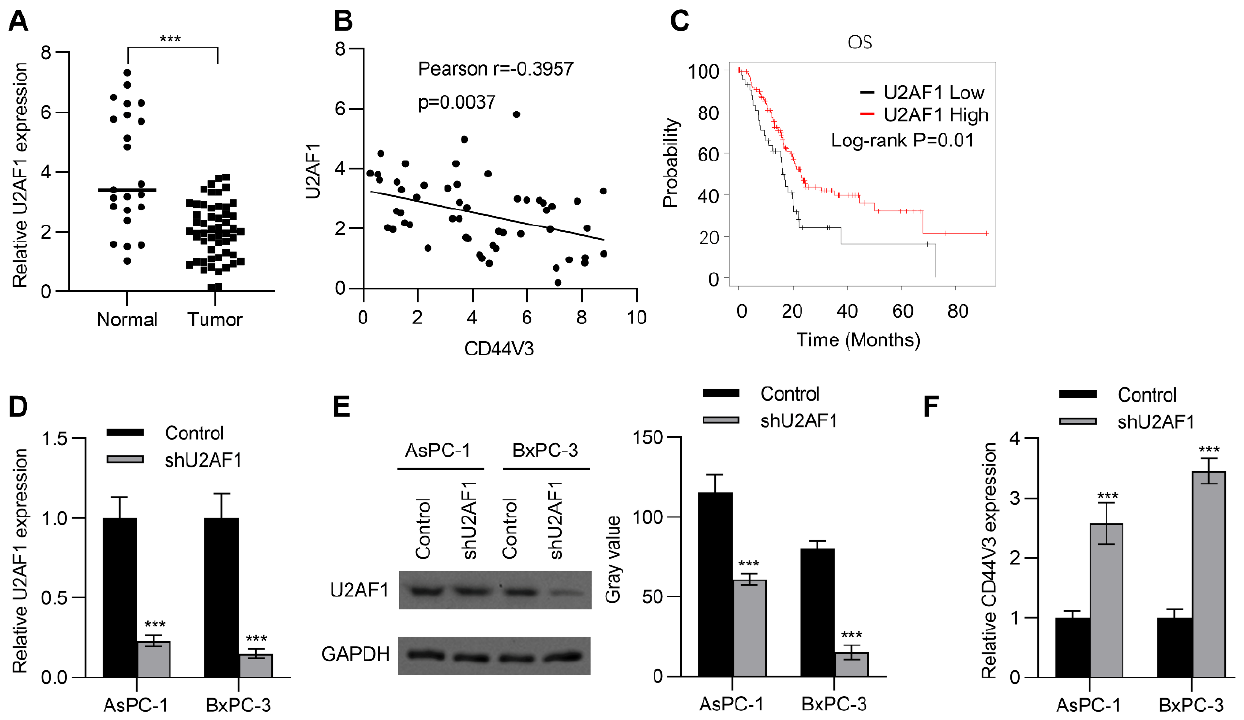
Figure 2. U2AF1 regulates CD44V3 splicing. ( A ) The U2AF1 levels in normal and pancreatic tumor tissues were analyzed by qPCR. ( B ) The correlation between U2AF1 and CD44V3 in pancreatic cancer patients was determined by qPCR. ( C ) Kaplan–Meier plots of overall survival in pancreatic cancer patients stratified according to their U2AF1 levels. The Kaplan–Meier Plotter was used to analyze the data. ( D , E ) The U2AF1 levels in AsPC-1 or BxPC-3 cells transfected with U2AF1 shRNA were analyzed by qPCR ( D ) or Western blot ( E ). ( F ) The CD44V3 levels in AsPC-1 or BxPC-3 cells transfected with U2AF1 shRNA were analyzed by qPCR. The data are presented as mean ± S.D. *** p < 0.001.